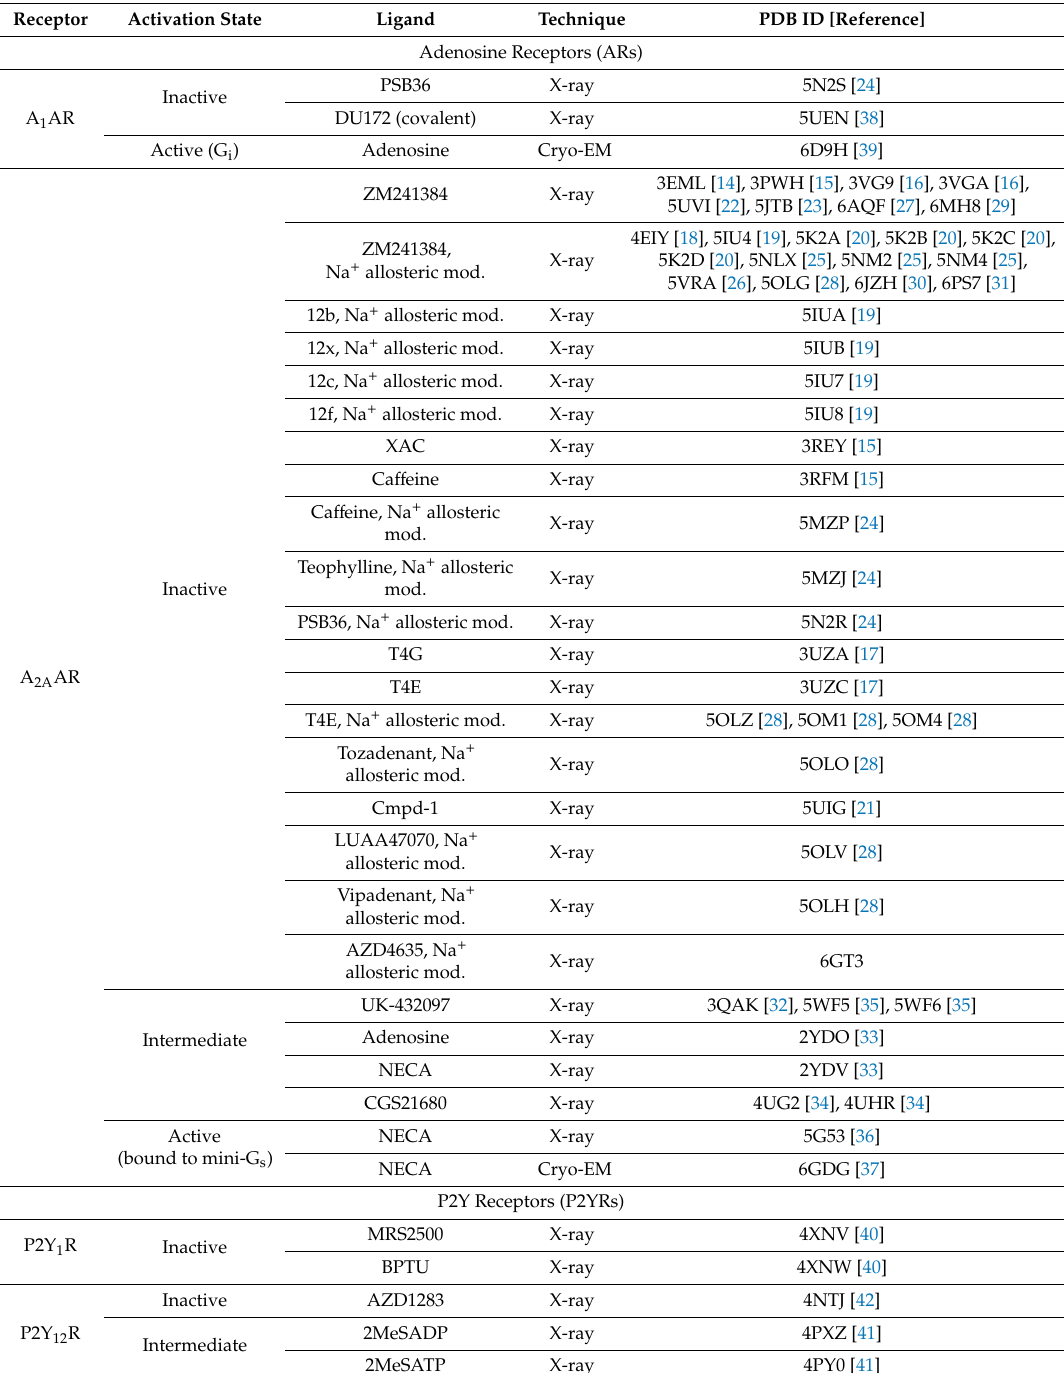
Table 2. Reported AR and P2YR experimental structures (in the Protein Data Bank (PDB)) and their